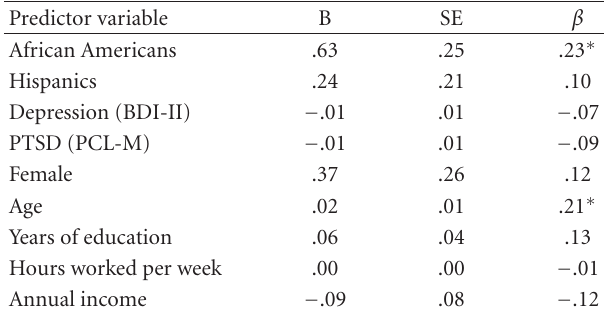
Table 6: Regression analysis summary for minority status as a predictor of religious coping.